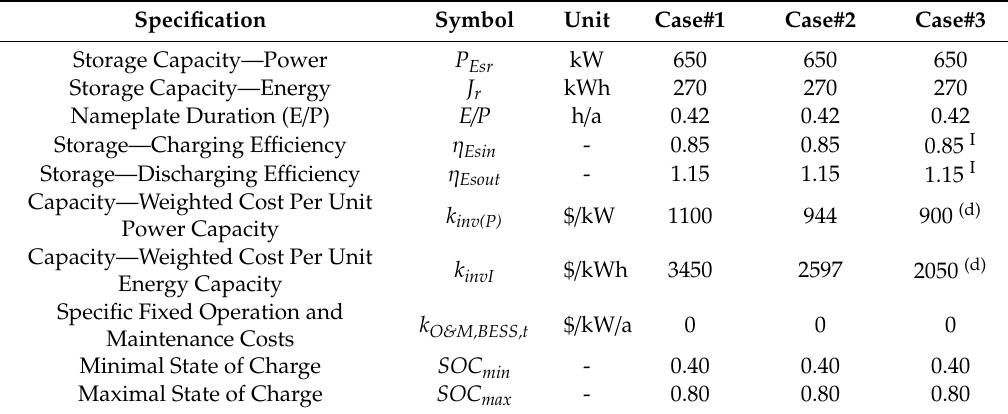
Table 5. Data for energy storage technology—lithium-ion battery energy storage system. Note: Data sources: (c) [43], (d)